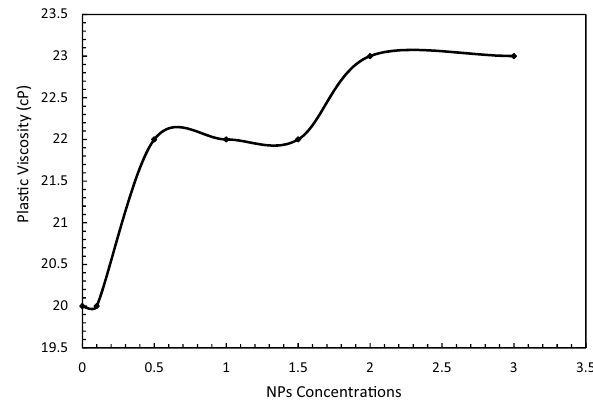
Fig. 4 Effect of concentrations of NPs on Viscosity at different shear rate